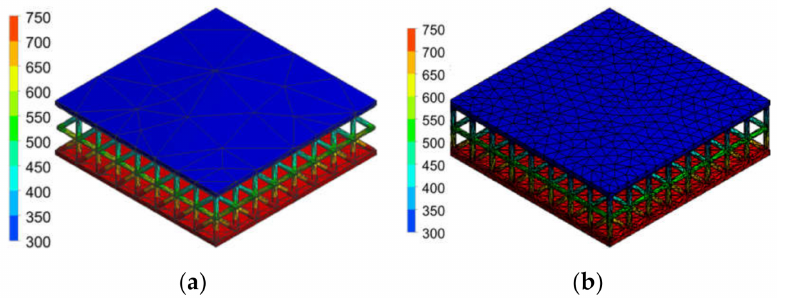
Figure 9. Temperature field distribution of two lattice structures under temperature load: ( a ) X; ( b ) star.